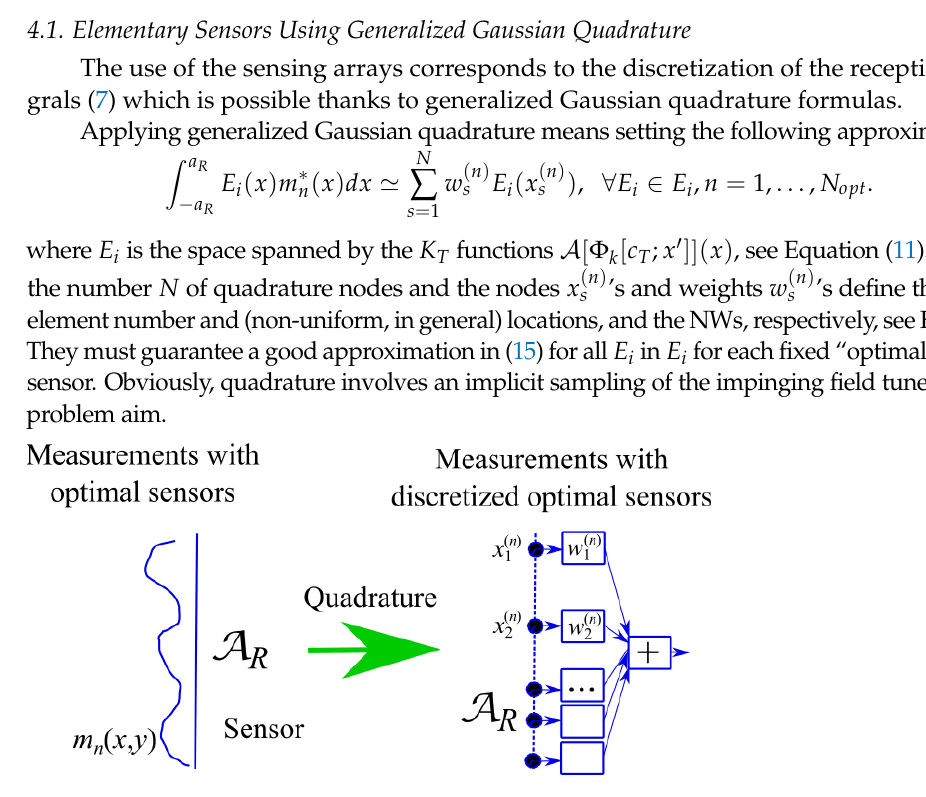
Figure 3. Subsequent use of the “optimal virtual” sensors to measure the transmitted field according to Equations (7) and (8).